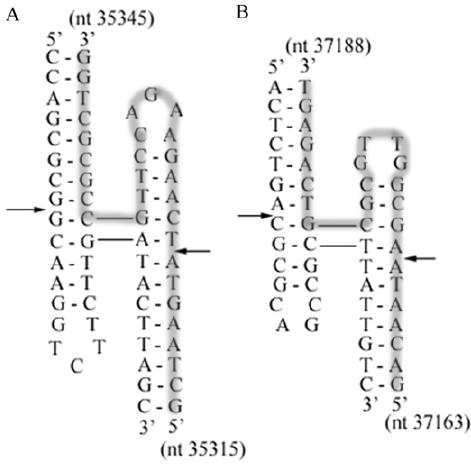
Figure 4. Structures of four-way junctions in gene 18.5 of T3 and T7. (A) T3 nt 35315–35345 or equivalently T7 nt 37094–37124 (B) T7 nt 37163–37188. One of the strands is highlighted in grey. Endo I cutting sites are shown by arrows. doi:10.1371/journal.pone.0030954.g004 9 bases in incomplete homology with T3 5 9 overhang nt 33332– 33340 (Figure 5). Phage gp2.5 is a recombinase that can mediate single strand annealing [38]. The incomplete homologous T3 5 9 overhang is displaced and cleaved by T7 (or T3) gp6 exonuclease [39]. The gap is refilled by T7 gp5/Trx or E. coli DNA polymerase